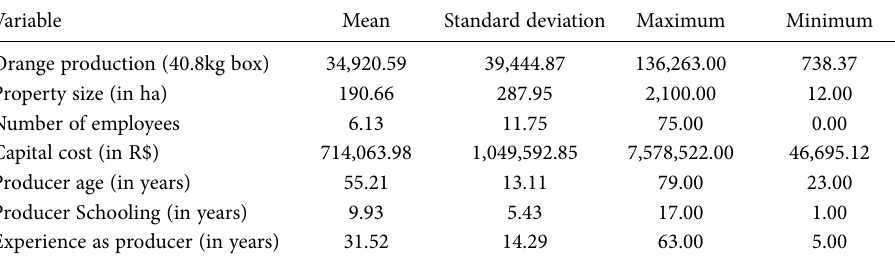
Table 2. Descriptive statistics of variables employed in producer efficiency model, 2010. Variable Mean